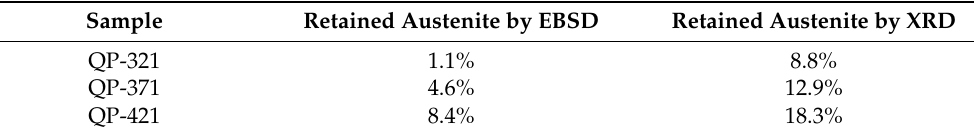
Table 3. Volume fraction of retained austenite measured by EBSD and XRD.